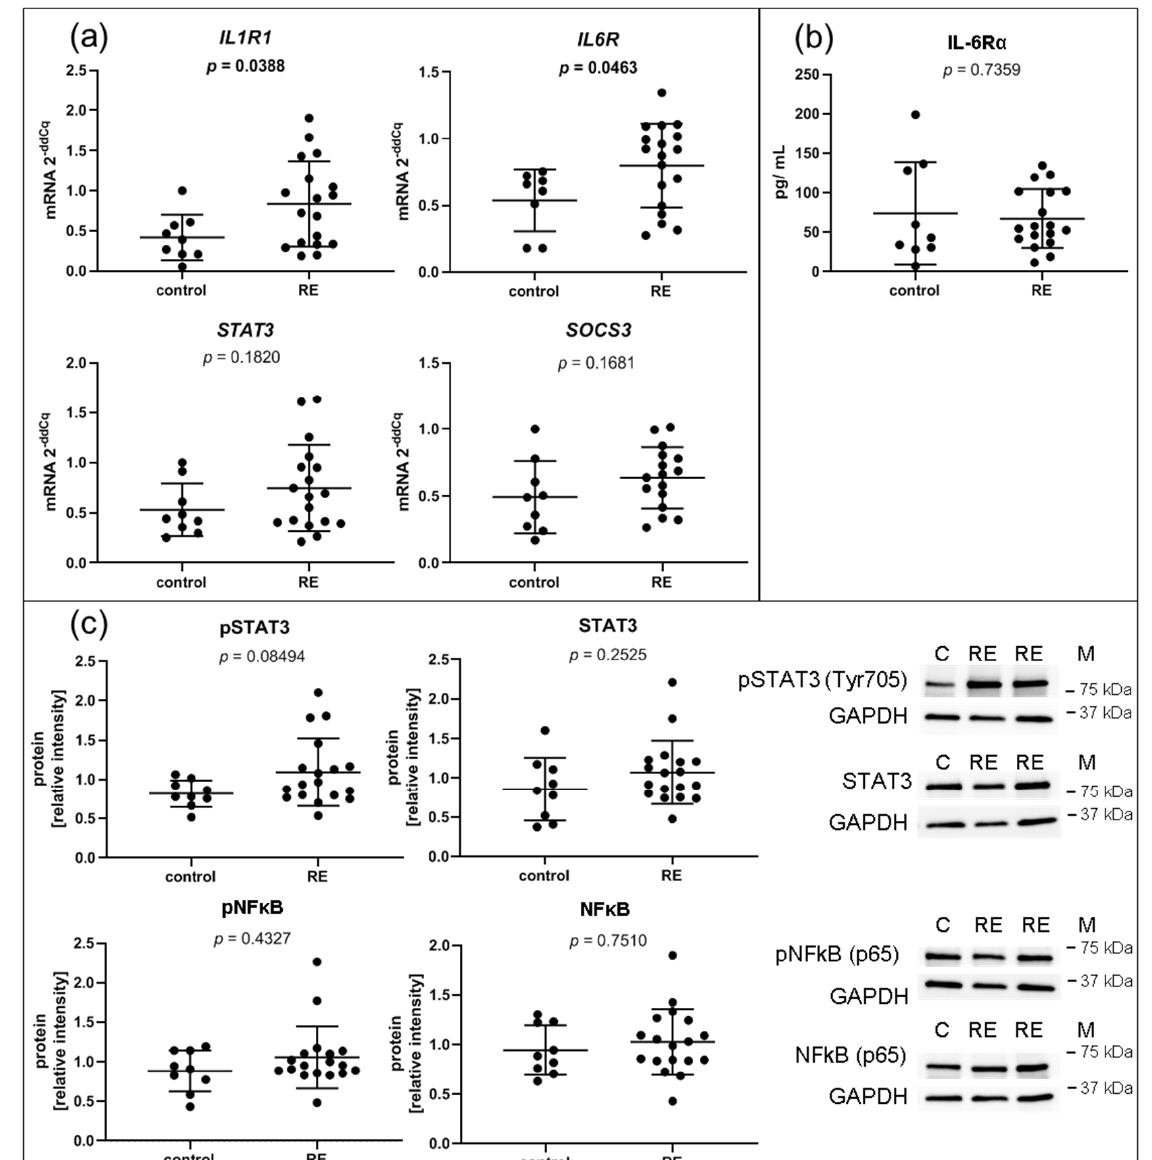
Figure 6. Inflammation: VFF from RE patients have increased gene expression levels of inflammatory cytokine receptors, but no intrinsically higher activation of IL1 β / NFkB or IL-6/ STAT3 pathways. ( a ) Gene expression of most regulated single components of significantly regulated hallmark pathway IL-6/JAK/STAT3 signaling, including IL1R1 , IL-6R , STAT3 and SOCS3 were evaluated by qPCR; ( b ) presence of soluble IL-6R α protein in the supernatant was measured by Luminex; ( c ) densitometric analysis of proteins by Western blots for pSTAT3 (Tyr705), STAT3, pNFkB (p65) and NFkB (p65); Graphs show mean ± SD of 8 to 18 samples per group (control: n = 8–9, RE: n = 18). Groups were compared by Student‘s t -test, with Welch‘s correction if variances differed; in case of non-Gaussian distribution, Mann–Whitney rank test was conducted. p ≤ 0.05 was considered significant. C = control, RE = Reinke‘s edema, M = marker.